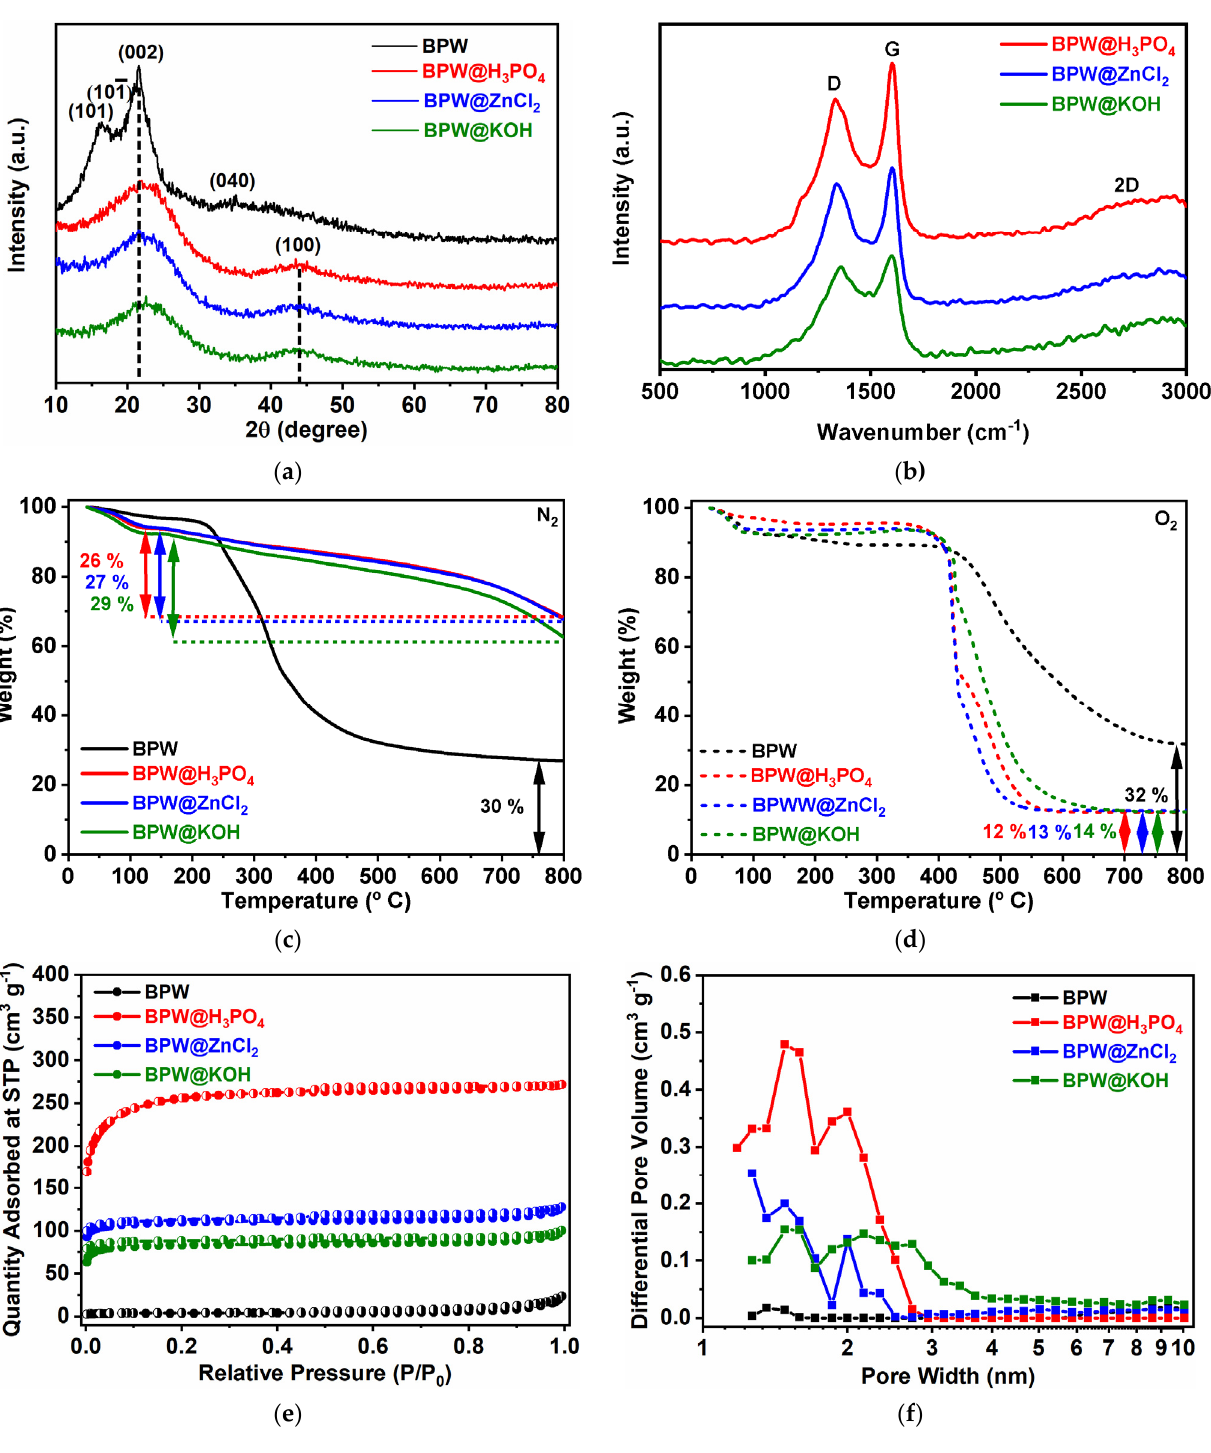
Figure 2. ( a ) XRD patterns of BPW raw material and successive activated carbons. ( b ) Raman spectra of raw material and activated carbons. ( c ) N 2 ( d ) O 2 TGA curves of BPW raw material and activated carbons. ( e ) Nitrogen adsorption-desorption isotherms of raw material and activated carbons. ( f ) DFT pore size distribution of BPW raw material and activated carbons. The different parameters extracted from the XRD analysis are shown in Table